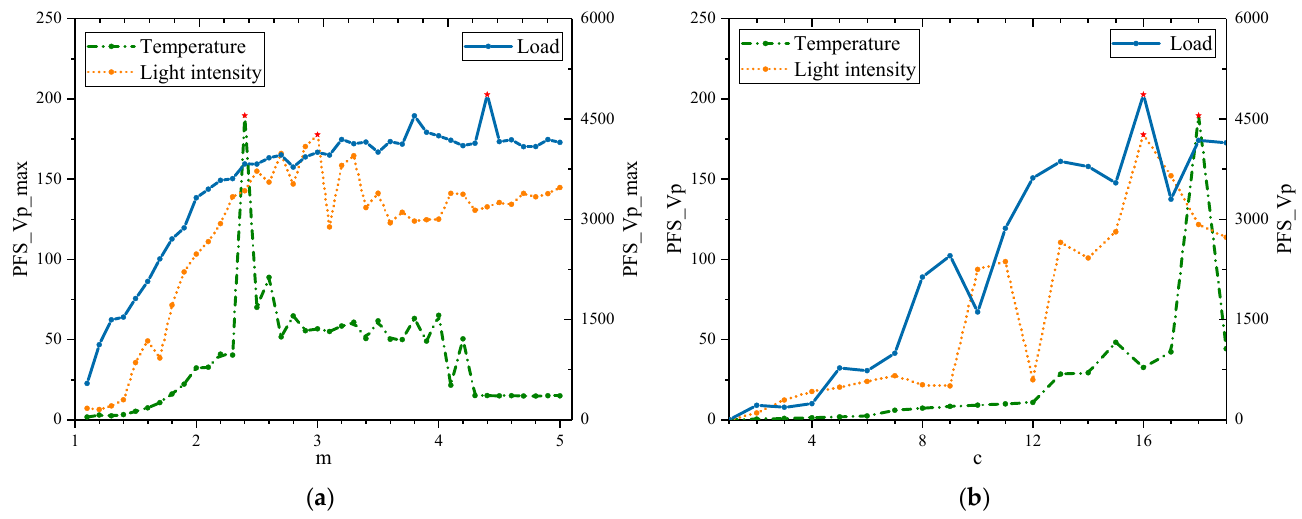
Figure 4. ( a ) The maximum value of clustering index under different values of m ; ( b ) the value of clustering index under different values of c when m takes the best value.